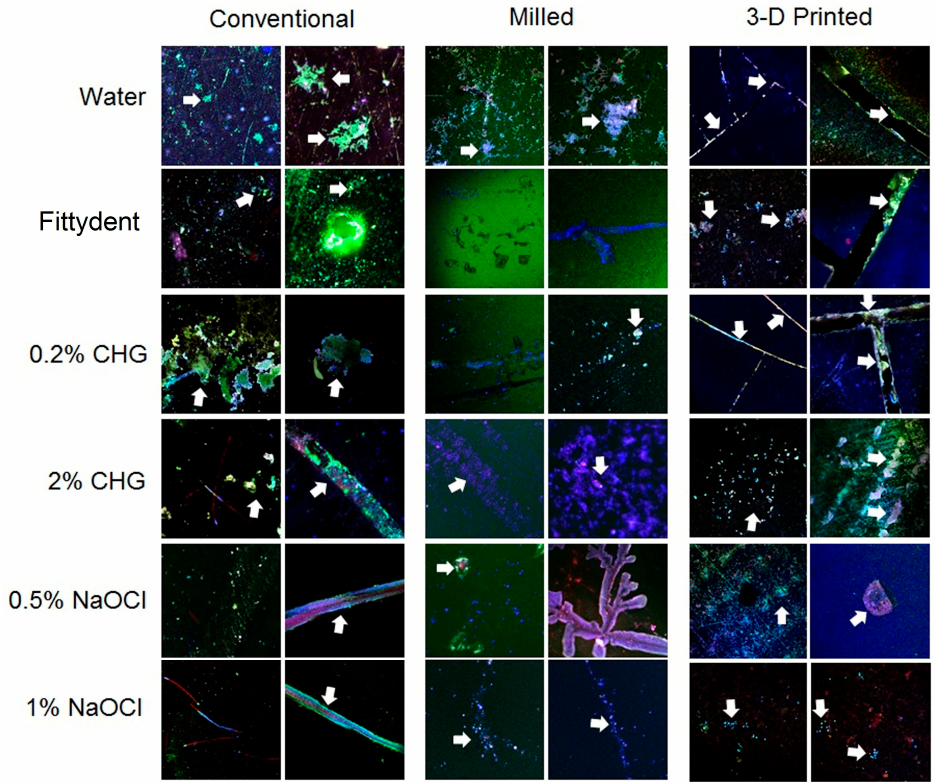
Figure 3. Confocal laser scanning microscopy (CLSM) images of the post-treatment discs from each material group. The sample discs were stained with HOECHST33342 (blue), Cell Tracker™ Green (green), and Actin Red (red). White arrow shows adherent microbes on the discs. Conventional and 3D-printed discs showed most of the microbe growth as evident in the images. Overall, Sodium- Hypochlorite-treated samples showed lowest microbe growth in comparison to other groups.